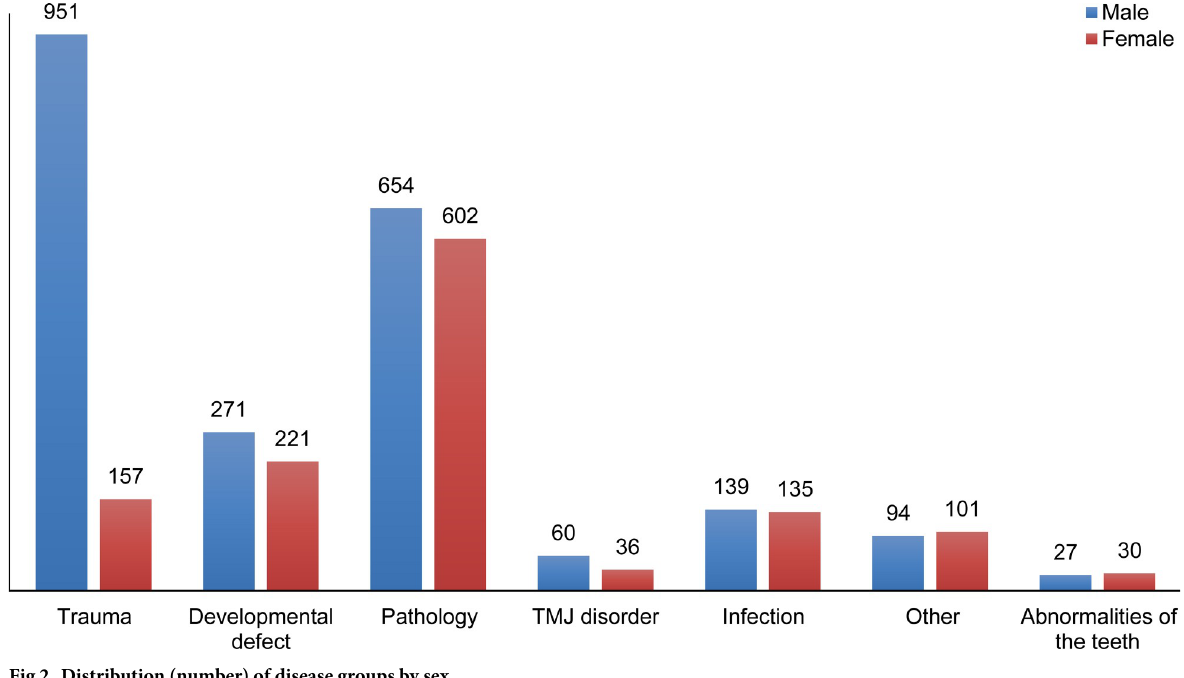
Fig 2. Distribution (number) of disease groups by sex.